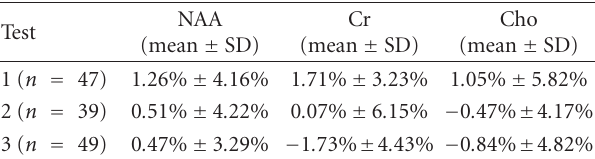
Table 2: Comparisons of signal amplitudes acquired on a human subject with or without spacing between slices. Means and SD were calculated using (2). n is the number of selected voxels in the 4th slice. The TR was 2.3 s for tests 1 and 2, and 3.0s for test 3. NAA Test